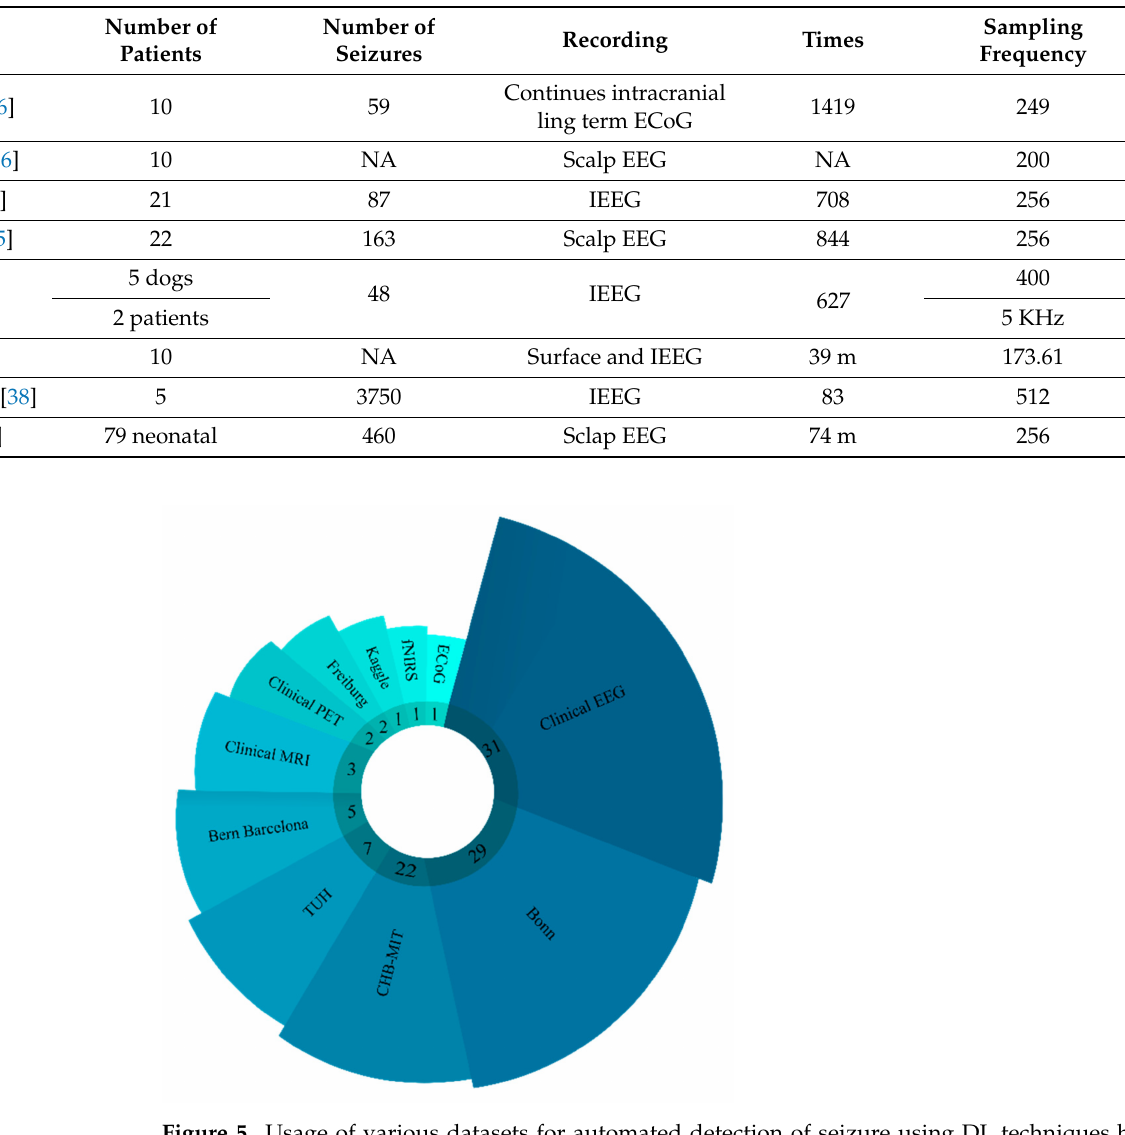
Figure 5. Usage of various datasets for automated detection of seizure using DL techniques by various